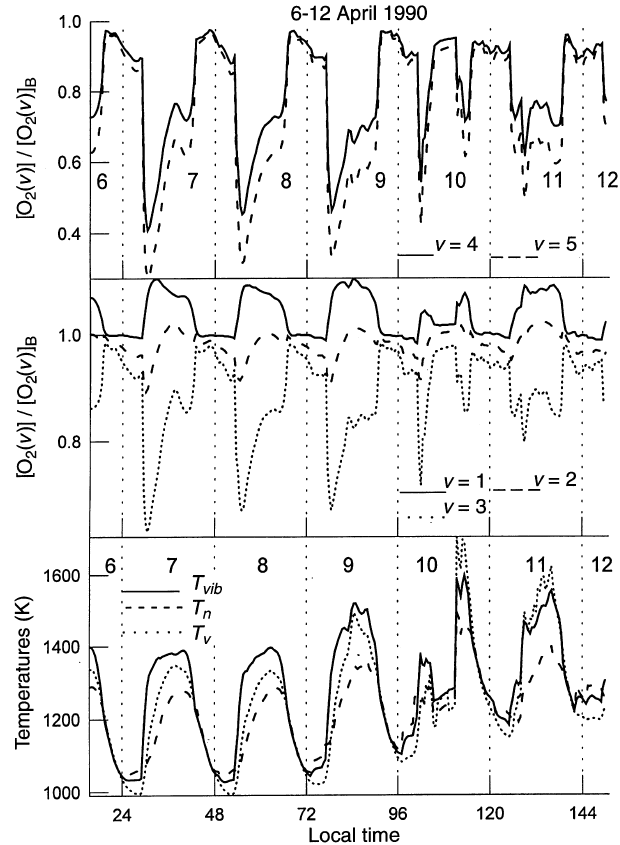
Fig. 4. The time variations of the vibrational temperatures of (cid:137) O 2 ] and (cid:137) N 2 ], the neutral temperature ( bottom panel ), and populations of the first five vibrational levels of O 2 (cid:133) v (cid:136) 1 ; 2, and 3 at the middle panel and v (cid:136) 4 and 5 at the top panel ) in comparison with the Boltzmann distribution of Eq. (12) during the 6–12 April period at the F2 peak altitude. The solid lines show the modeled T vib ; (cid:137) O 2 (cid:133) 1 (cid:134)(cid:138) = (cid:137) O 2 (cid:133) 1 (cid:134)(cid:138) , and B , the dashed lines show the modeled T n ; (cid:137) O 2 (cid:133) 2 (cid:134)(cid:138) = (cid:137) O 2 (cid:133) 4 (cid:134)(cid:138) = (cid:137) O 2 (cid:133) 4 (cid:134)(cid:138) B (cid:137) O 2 (cid:133) 2 (cid:134)(cid:138) , and (cid:137) O 2 (cid:133) 5 (cid:134)(cid:138) = (cid:137) O 2 (cid:133) 5 (cid:134)(cid:138) , and the dotted lines show the B B modeled T v , and (cid:137) O 2 (cid:133) 3 (cid:134)(cid:138) = (cid:137) O 2 (cid:133) 3 (cid:134)(cid:138) . The approach given by Eqs. (5), B (8), and (14) for K